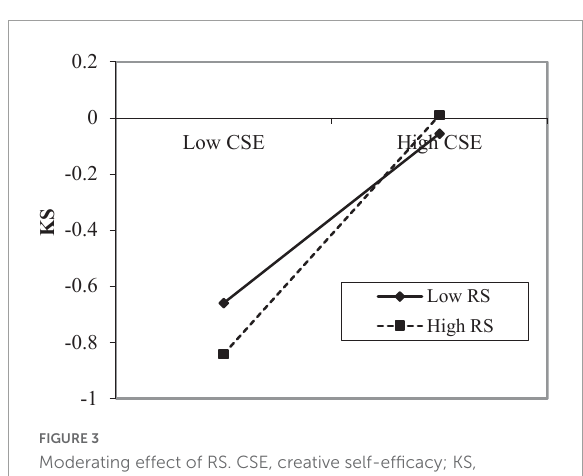
FIGURE3 Moderating effect of RS. CSE, creative self-efficacy; KS, knowledge sharing; RS, research